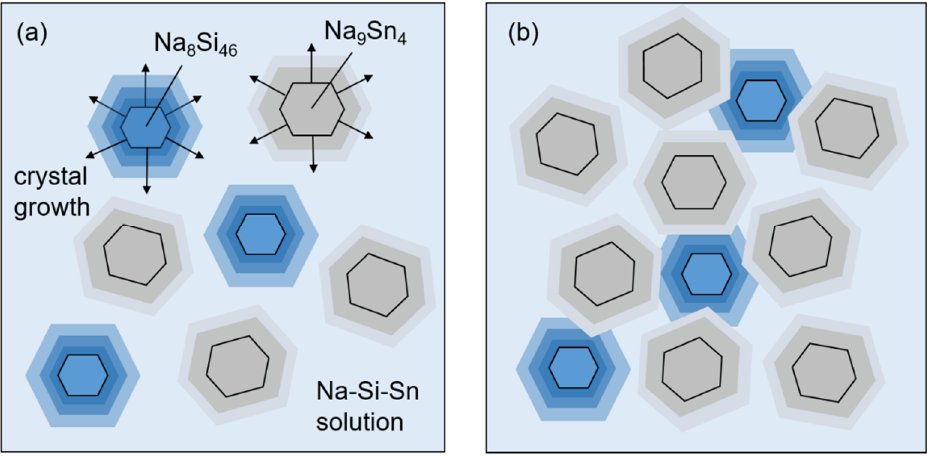
Figure 3. Schematic diagrams of the crystal growth processes conducted at x = ( a ) 0.5 and ( b ) 1.0.